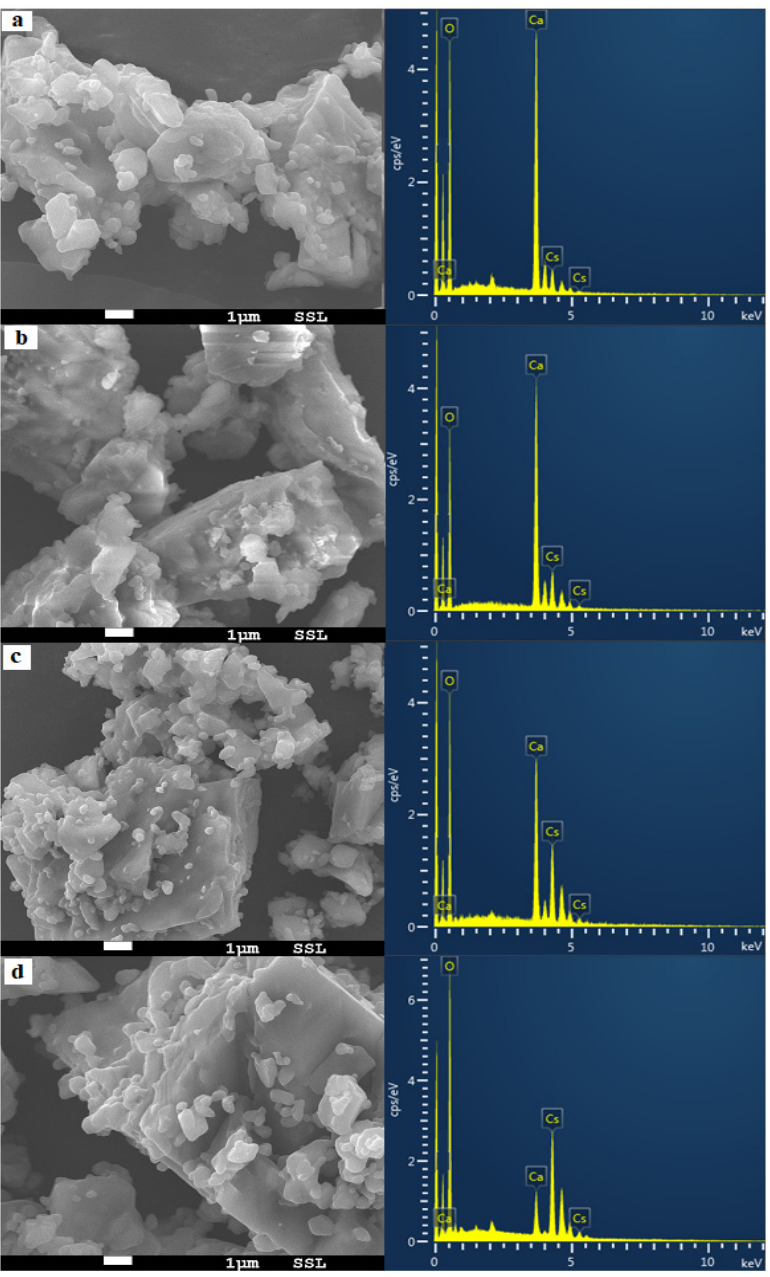
Figure 2. Catalyst analysis by SEM and EDS: ( a ) lime (CaO) modified by 10 wt.% of caesium oxide, ( b ) lime modified by 15 wt.% of caesium oxide, ( c ) lime modified by 20 wt.% of caesium oxide and ( d ) lime modified by 25 wt.% of caesium